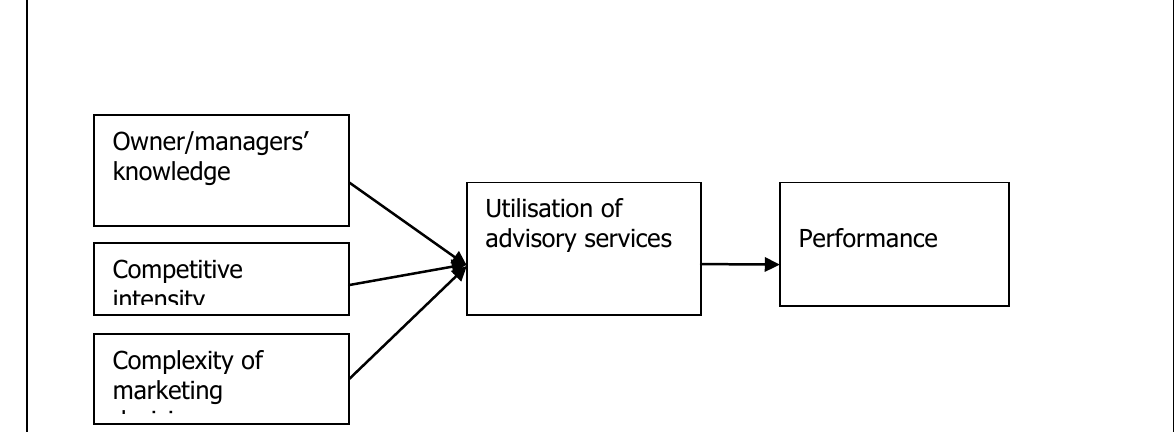
Figure 1: Research